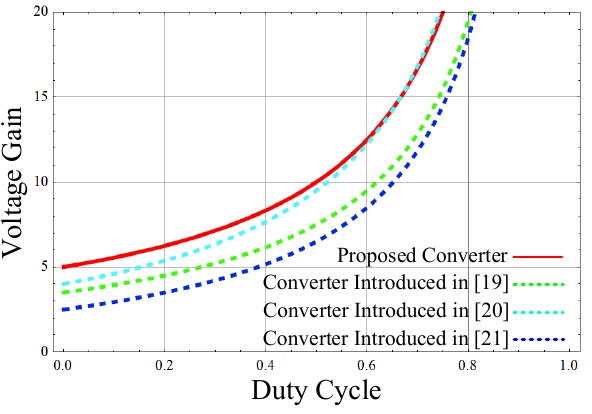
Figure 7. Voltage gain comparison among the proposed converter and conventional converters in